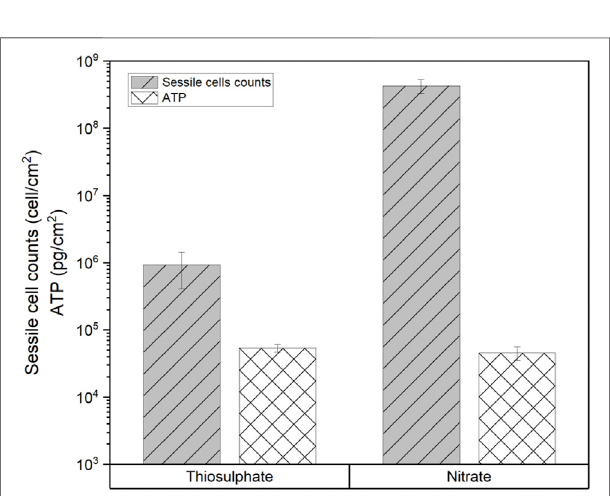
FIGURE 10 | Sessile cell counts and ATP level in bio fi lms formed by S. chilikensis after 16-days exposure to thiosulphate and nitrate reducing